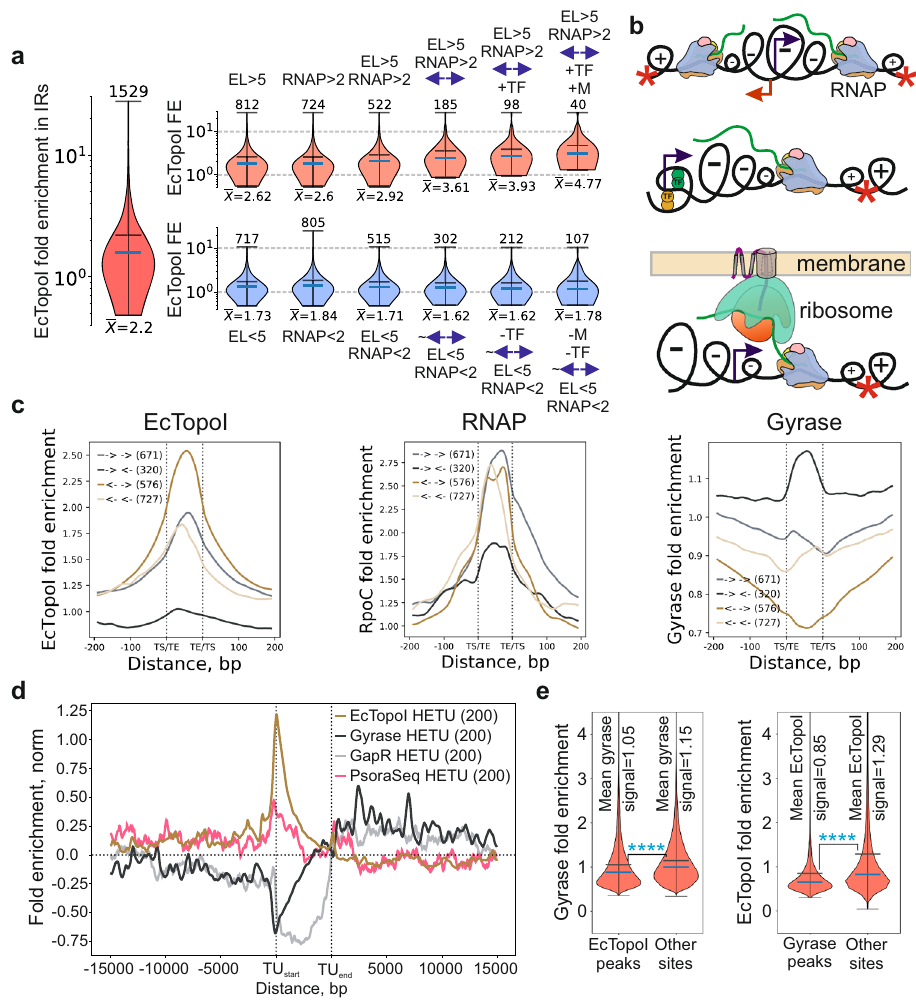
Fig. 3 | IR features associated with the increased EcTopoI enrichment and mutualexclusionofEcTopoIandDNAgyrasegenome-wide.a Cumulativeeffect of transcription and local topological barriers on EcTopoI fold enrichment (FE) in IRsforCTD-/Rif-condition.Violinplotsshowthecontributionofpositive(top)and negative (bottom) factors on EcTopoI enrichment in IRs, including the expression level of adjacent genes (EL, FPKM units), FE of RNAP (RNAP, FE units), the orien- tation of adjacent genes ( ←→ for divergent and ~ ←→ for not divergent orientation), annotated sites for transcription factors (+TF for at least one site is annotated and -TF if no sites are annotated), and membrane localization of proteins encoded by adjacentgenes(+Mforatleastonegeneencodesamembraneproteinand-Mifno such genes). The leftmost plot shows an overall EcTopoI fold enrichment in 1529 IRs. Means (numeric values are shown below) and medians are shown with hor- izontal black and blue lines, respectively; vertical axes are log-scaled. b Graphical